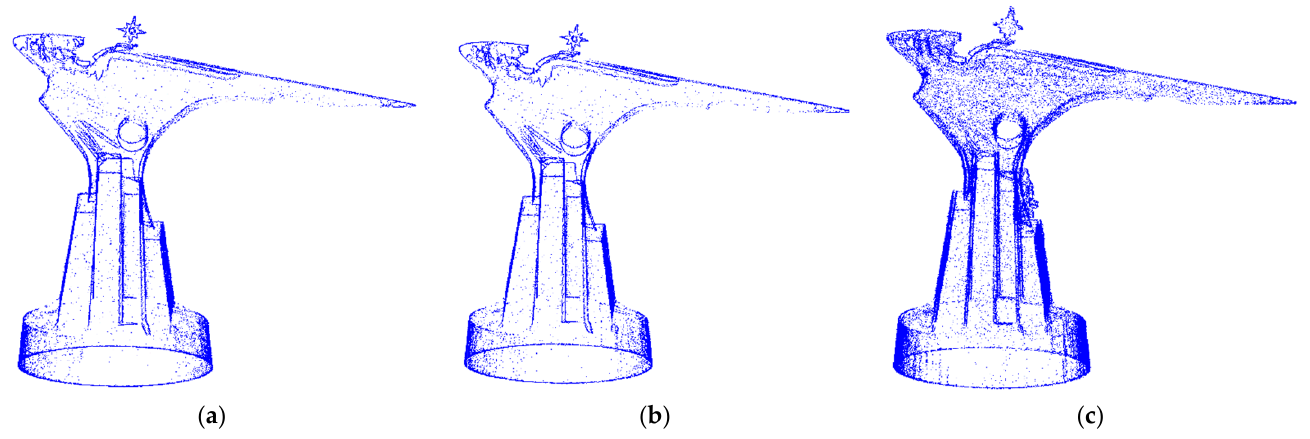
Figure 17. Boundary feature point extraction results. ( a ) TLS point cloud boundary extraction re- sults. ( b ) The boundary extraction results of point cloud fusion extracted by the research method. ( c ) Result of boundary extraction after direct fusion of point clouds.